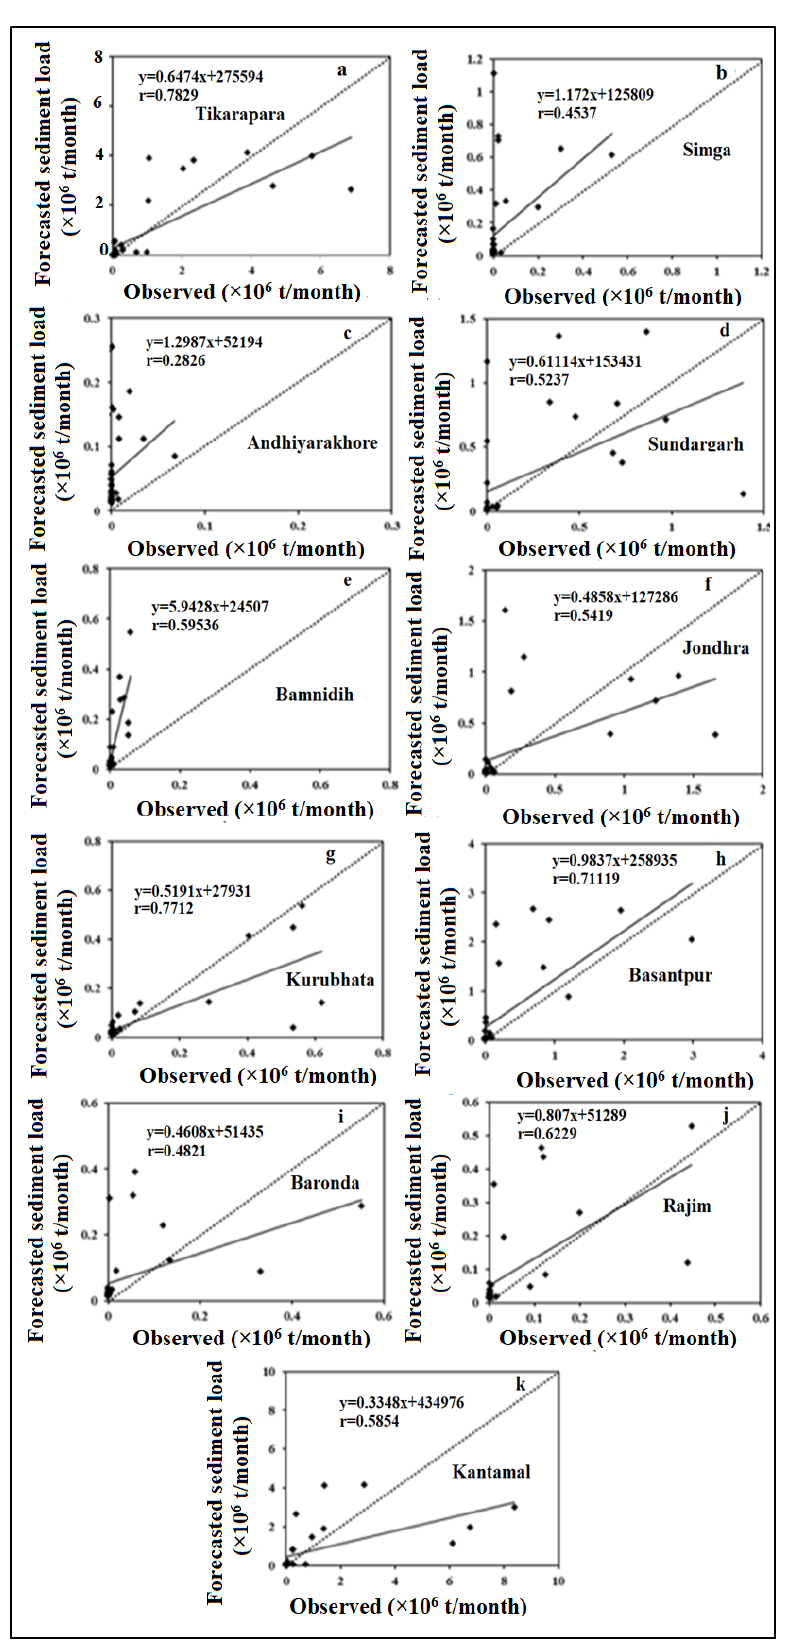
Figure 8. Scatter plot of the actual and forecasted SL of the ANN-MOGA-51 forecasting model during the testing phase (a-k) .